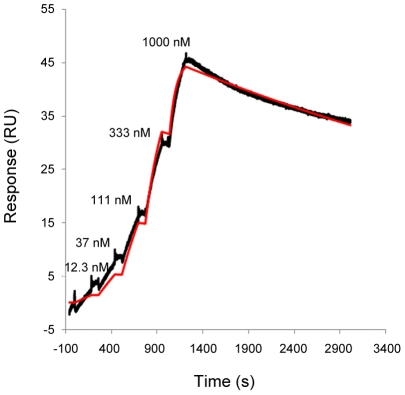
Representative sensorgrams for binding of monoclonal antibody Ab3 and DENV-1 NS1.Increasing concentrations of dengue-1 NS1 were sequentially injected onto 70 RU of Ab3 captured by anti-mouse IgG. The reference-subtracted data (black curve) were fitted using 1∶1 binding algorithm (red curve).